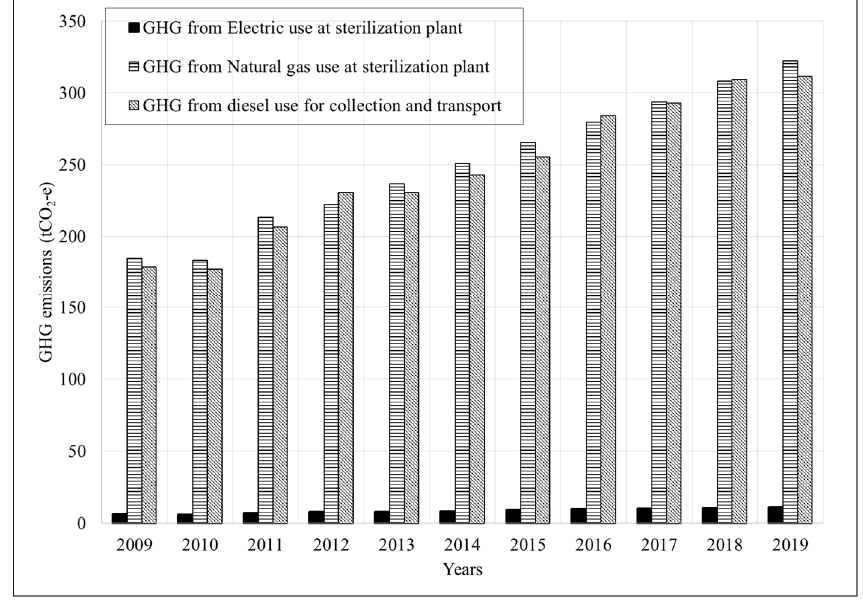
Figure 4. Amounts of GHG emissions from different fuels for biomedical waste collection, transport and treatment between 2009 and 2019.